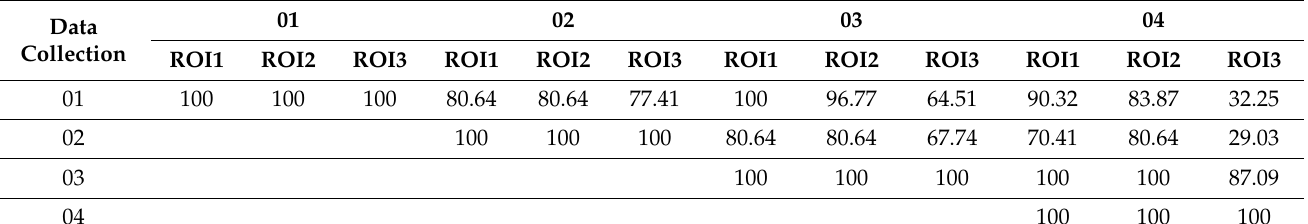
Table 2. Results of identification for the short- and long-term